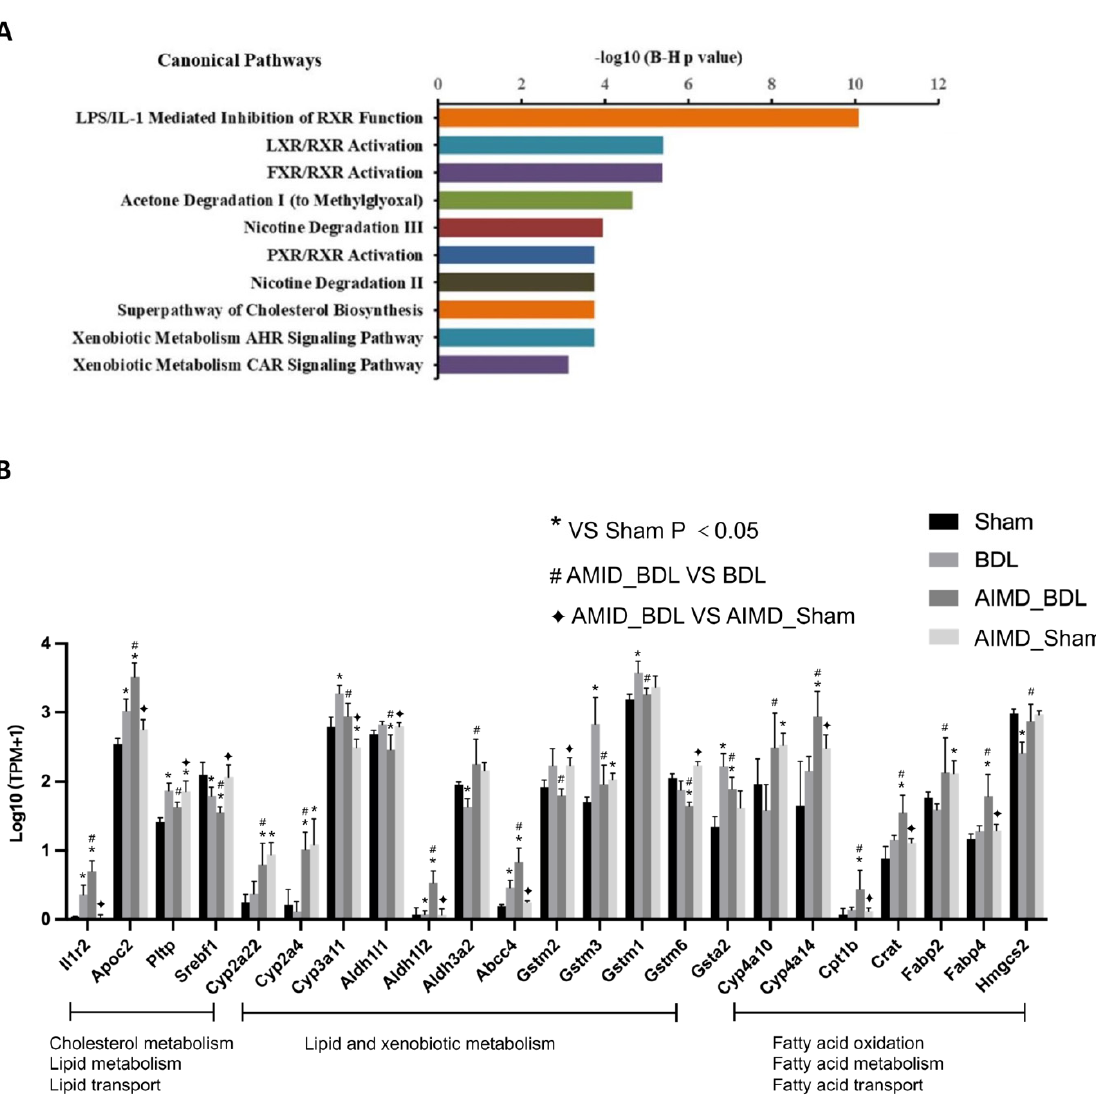
Figure 6. ( A ) Enriched IPA pathways of the DEGs between BDL group and AIMD_BDL group ( − log10 (BH p -value), one − sided Fisher’s exact test). ( B ) The key molecules of the LPS/IL − 1 Mediated Inhibition of RXR Function pathway in BDL mice, which mainly involved lipid and xenobiotic metabolism, fatty acid oxidation, and fatty acid transport. * p < 0.05 vs. Sham group; # p < 0.05 AIMD_BDL group vs. BDL group; (cid:70) p < 0.05 AIMD_BDL group vs. AIMD_Sham